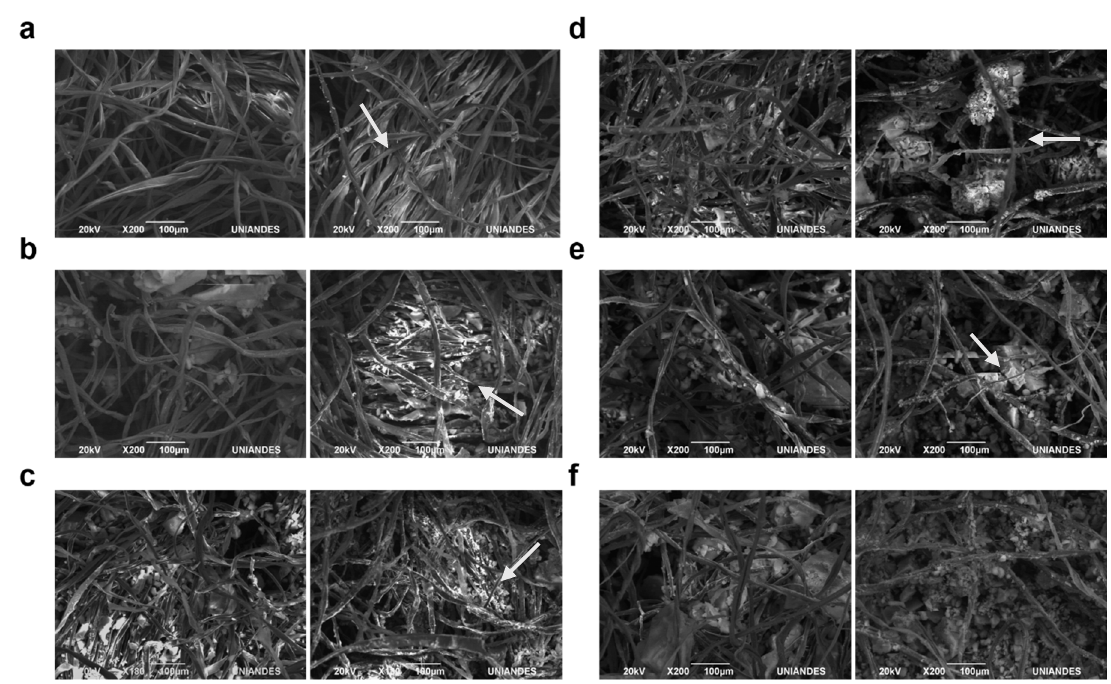
Figure 7. Backscattered electron (BSE) images of the biofilters before and after decolorization assays. ( a ) before (left) and after (right) of Free, ( b ) before (left) and after (right) of IL, ( c ) before (left) and after (right) of FreeNW, ( d ) before (left) and after (right) of ILNW, ( e ) before (left) and after (right) of FreeNA, and ( f ) before (left) and after (right) of ILNA. White arrows point to deposits after decolorization. These are most likely attributed to byproducts of the reaction that deposit along the fibers of the filter.